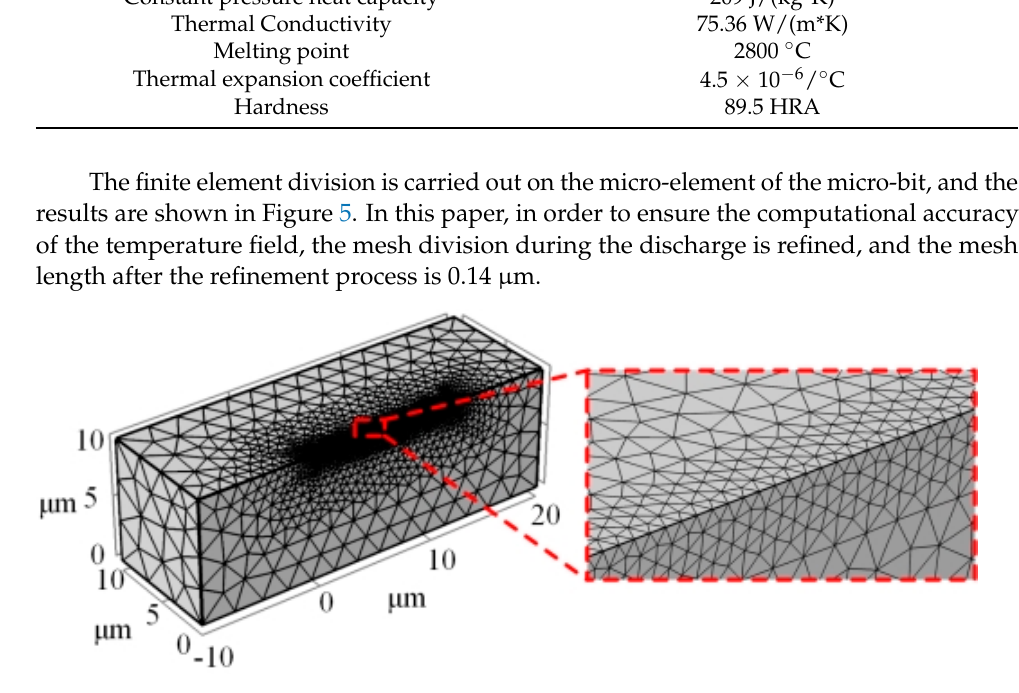
Figure 5. Finite element division of the micro-element of the micro-bit.